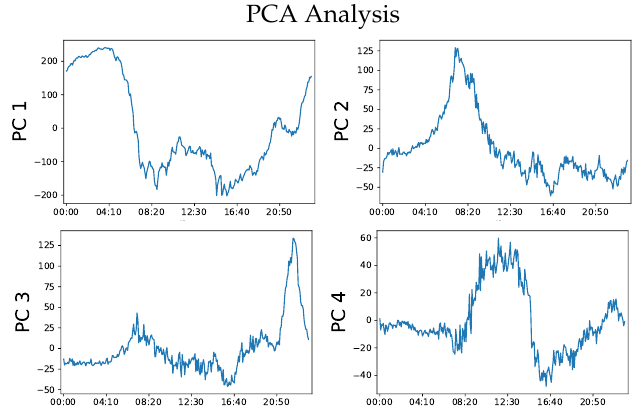
Figure 5. Figure depicting the first four (PCs with the largest eigen values in the PCA analysis of the Dodgers loop sensor dataset). PC 2 capture the dynamics of the morning peak; PC 3 represents the sharp traffic rise due to the evening baseball game, which commonly occurs on weekdays and Saturdays; and PC 4 captures the dynamics of the weekend light midday